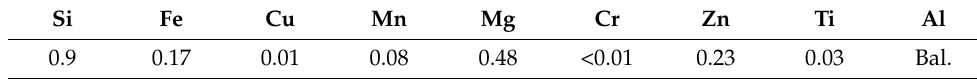
1 s − . The speckle pattern was painted on the specimen surface, and the deformation was measured by the digital image correlation method (Aramis 6.3). The deformation gradient was determined and the logarithmic strain was calcu- lated as ln U , where U denotes the right stretch tensor. A representative loga- rithmic strain was defined as the mean value of the logarithmic strain in a 50 mm × 12.5 mm area at the center of the specimen;